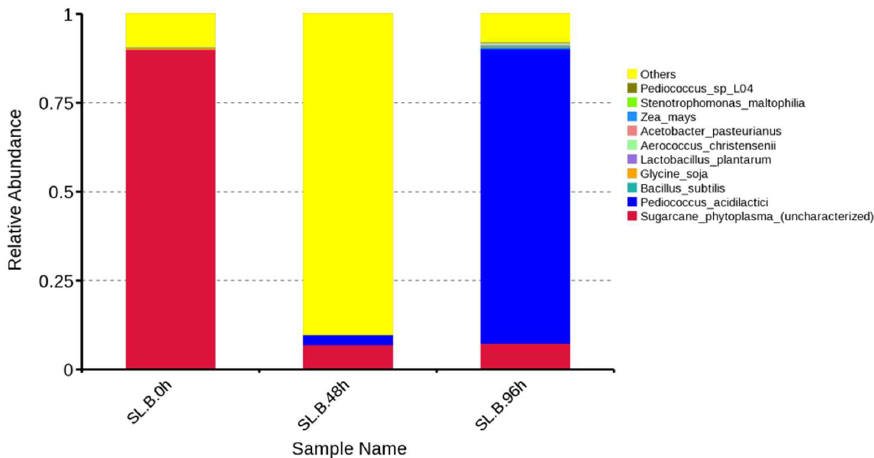
Figure 8. The histogram of the relative abundance of bacterial species at the species level. Abscissa (left to right): 0 h, 48 h, and 96 h fermentation samples; ordinate: relative abundance of species. “Others” represents the sum of the relative abundances of all species outside the top ten.